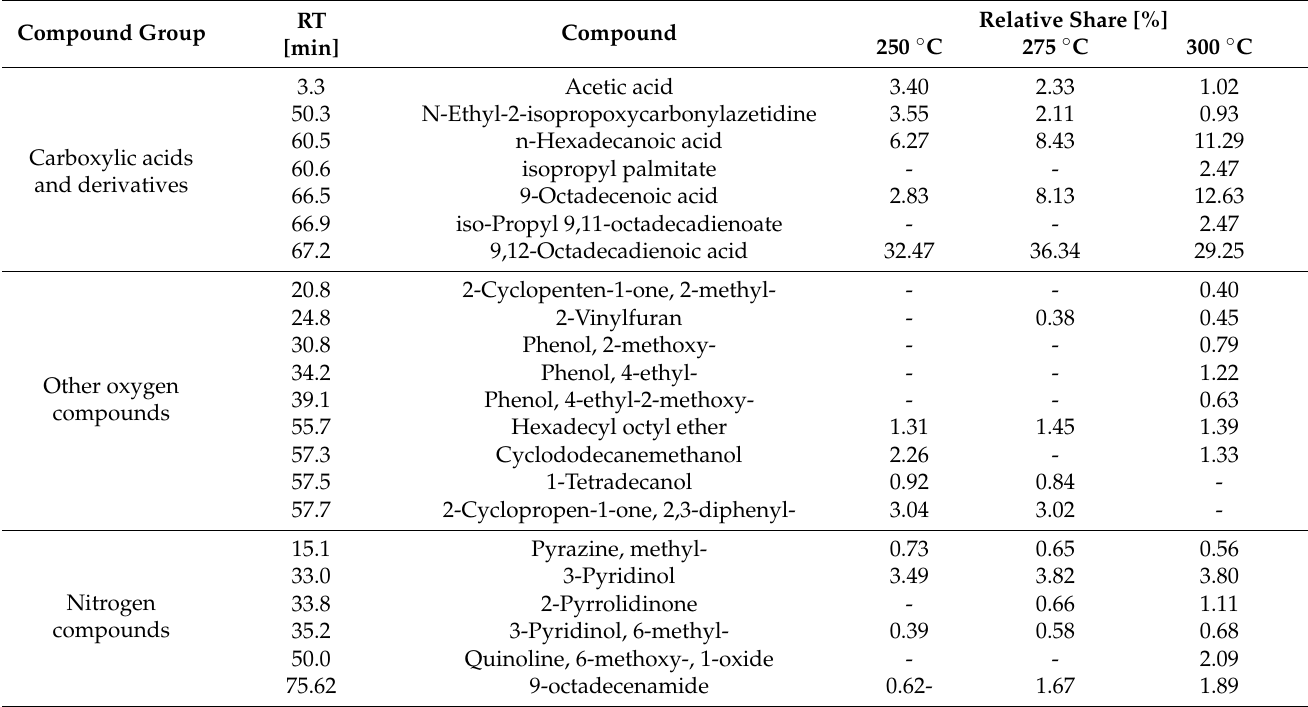
Table 3. Exemplary compounds identified in biocrudes obtained at different liquefaction temperatures for a biomass-to-solvent ratio equal to